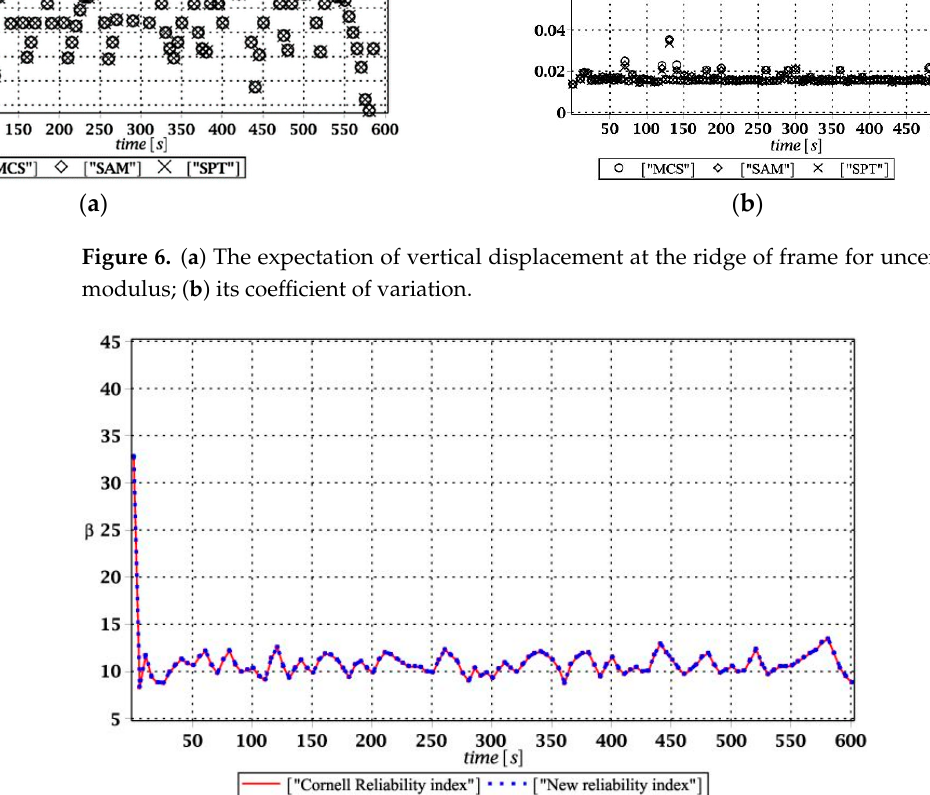
Figure 7. Comparison of dynamic reliability indices for uncertain snow load.